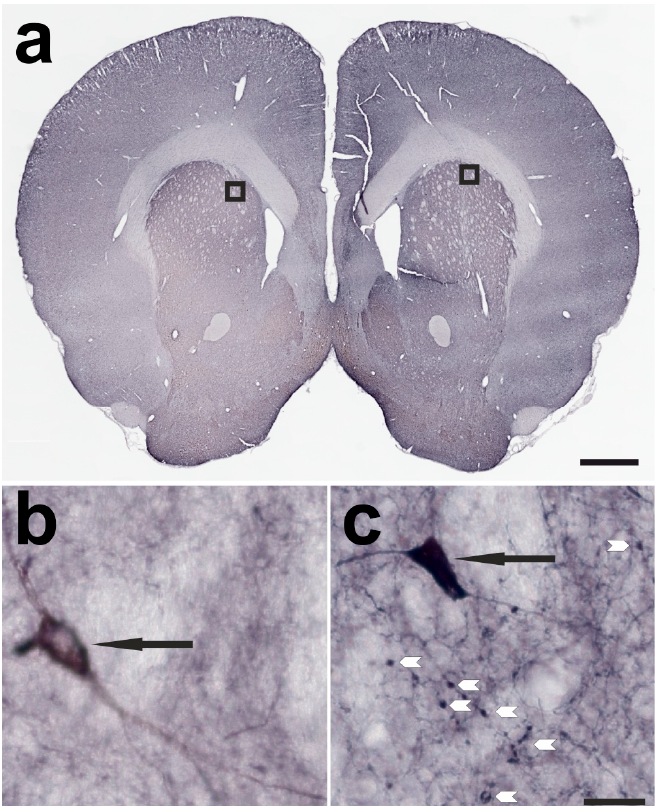
Figure 2. A frontal section through the telencephalon of a rat treated with 1 ng of BoNT-A in the right CPu one month earlier. The specimen was immunohistochemically stained against ChAT. In ( a ), an overview of the frontal section is presented. In ( b ), the marked box of the left (untreated) CPu is enlarged. A cholinergic interneuron is marked with a black arrow. In ( c ), a comparable area of the right (BoNT-A-treated) CPu is enlarged, also depicting a cholinergic interneuron, marked with a black arrow. Additionally, ChAT-positive BiVs (BoNT-A-induced varicosities) are marked with white arrowheads. The scale bar in ( a ) corresponds to 1 mm, the bar in ( c ) corresponds to 20 µm and is valid for ( b , c ).